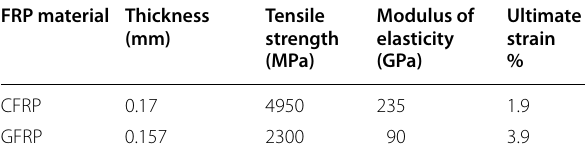
Table 2 Mechanical properties of FRP.